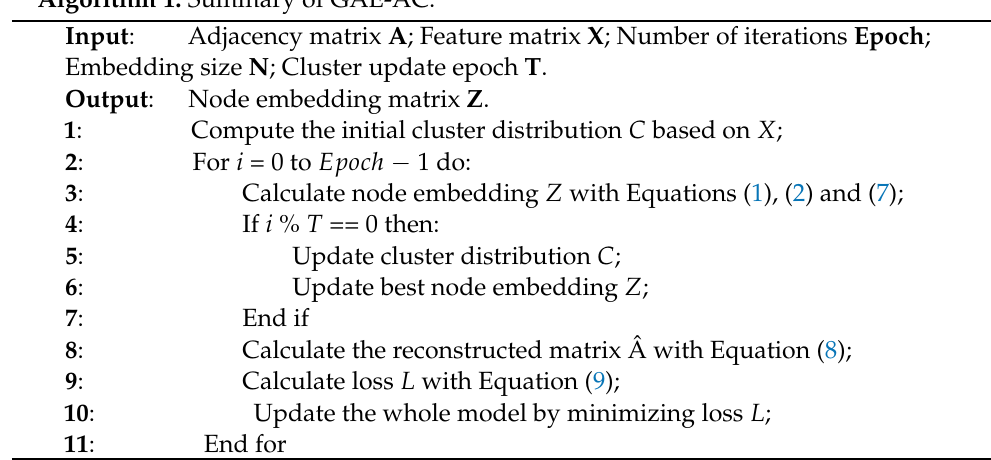
Algorithm 1: Summary of GAE-AC.